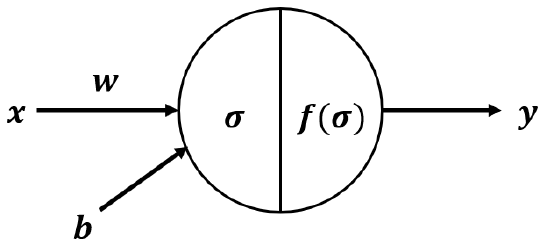
Figure 4. DNN structure. The variables used are bias b , input x , output y , weight w , calculation function σ and activation function f ( σ ) .